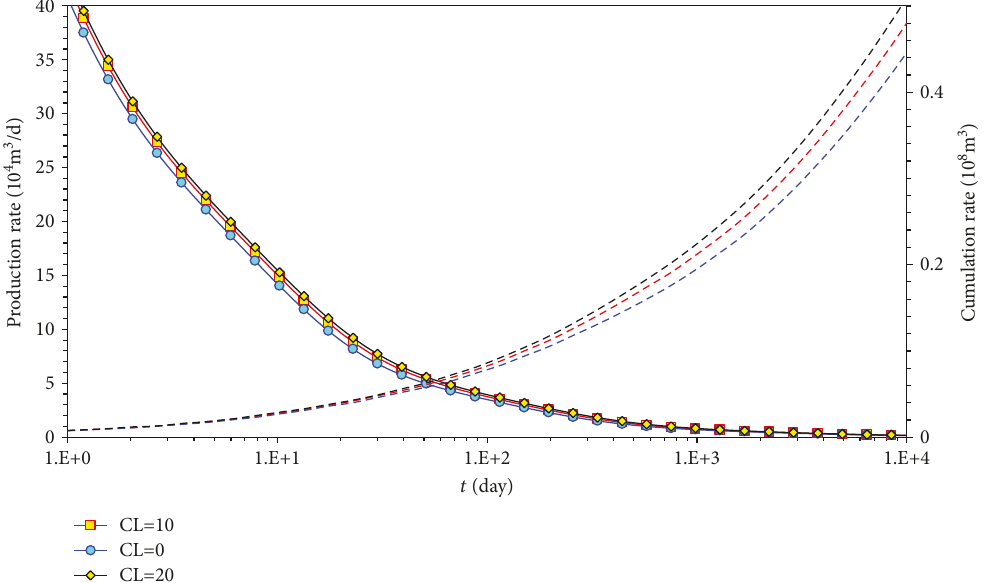
Figure 9: In fl uence of Langmuir volume on well production performance.